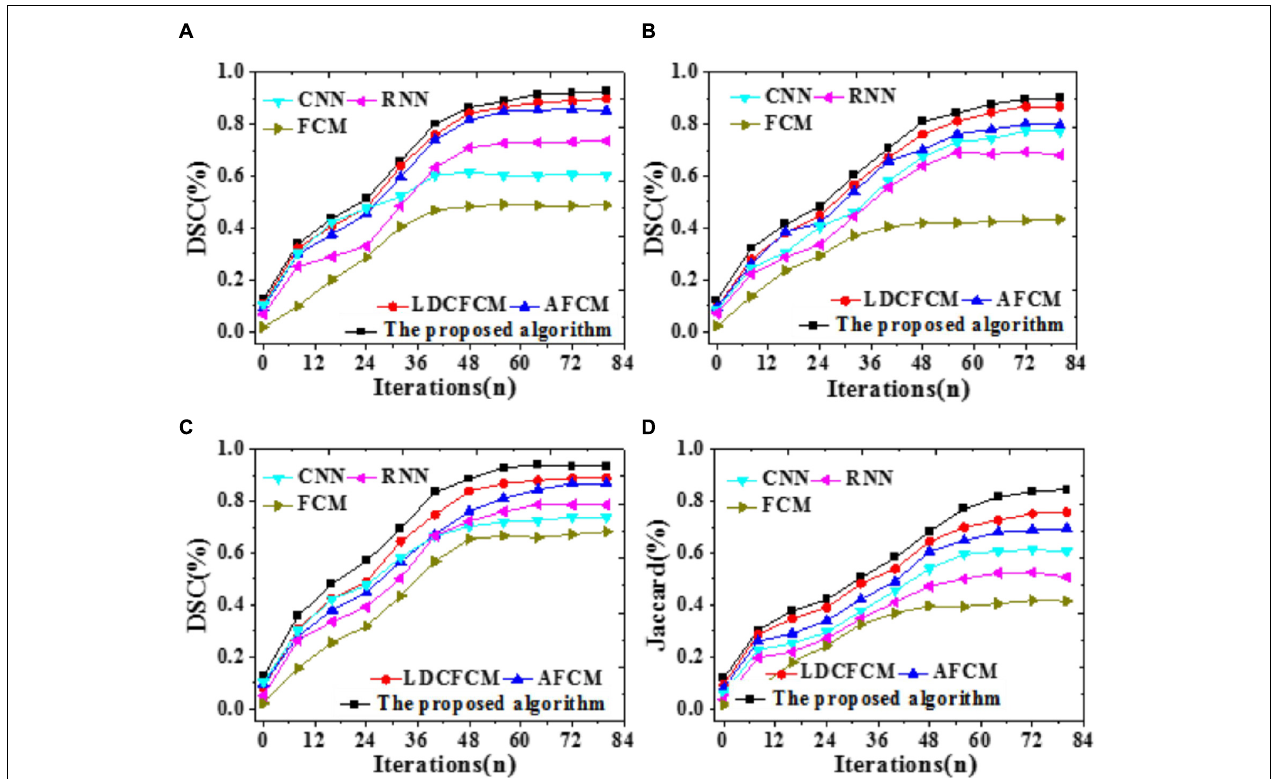
FIGURE 9 | Prediction accuracy indicators of different models for brain images with iterations. (A) Core tumor under DSC coefficient. (B) Enhancing tumor. (C) Whole tumor under DSC coefficient. (D) Jaccard